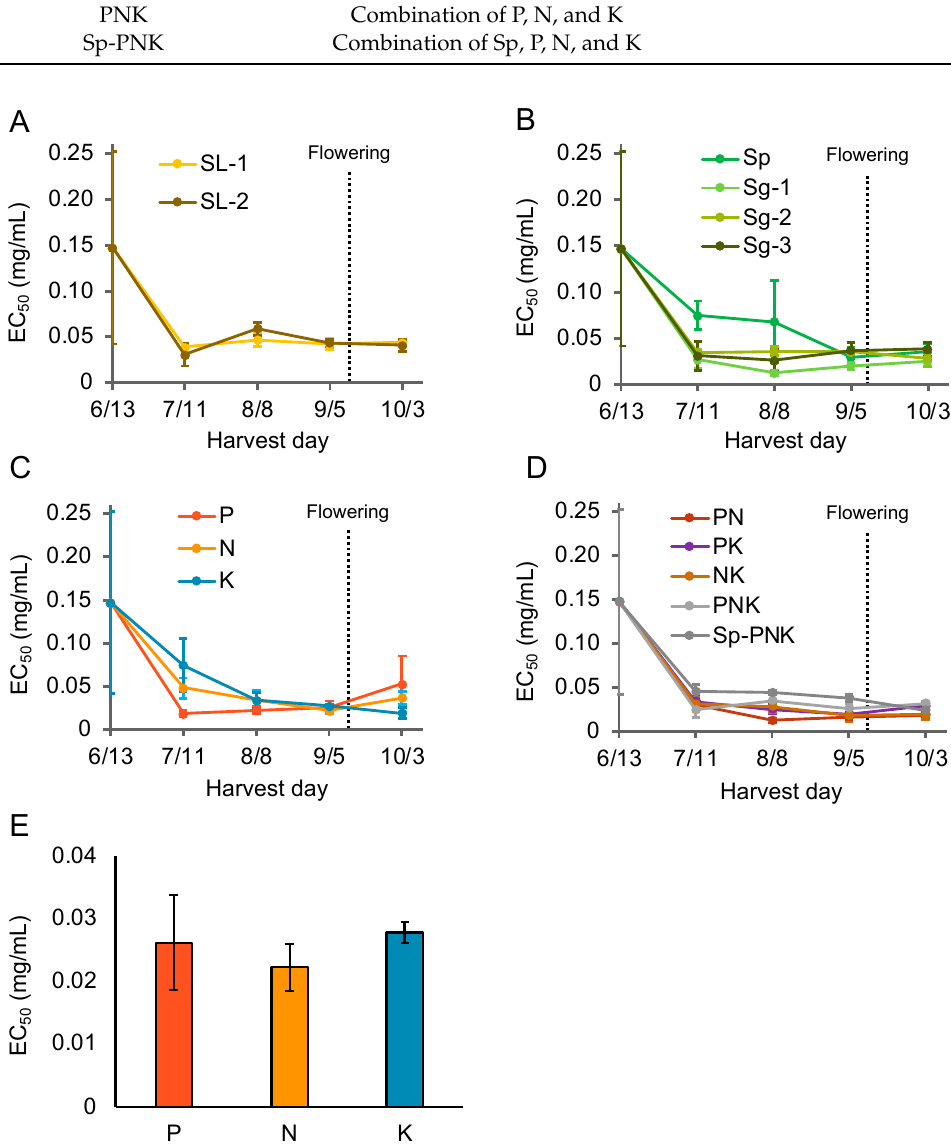
Figure 6. Nitrogen fertilization enhanced the A β aggregation inhibitory activity of Perilla frutescens var. crispa leaves. Plants were cultivated under multiple fertilization conditions and harvested every 4 weeks. ( A – D ) A β aggregation inhibitory activity of leaves harvested in 2019. Activity in leaves of